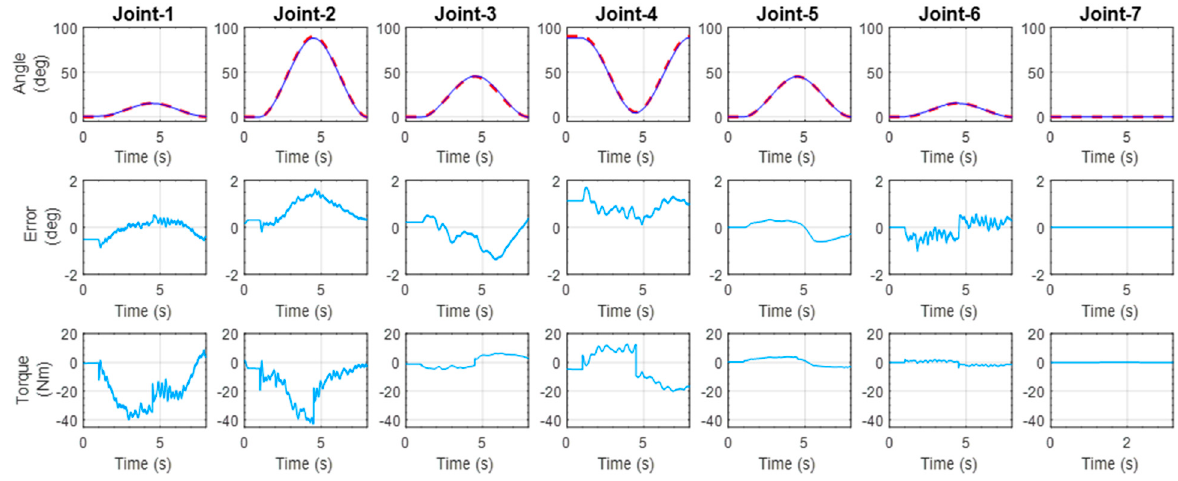
Figure 23. Experimental result for the movement (a diagonal reaching) of all joints, except joint-7.